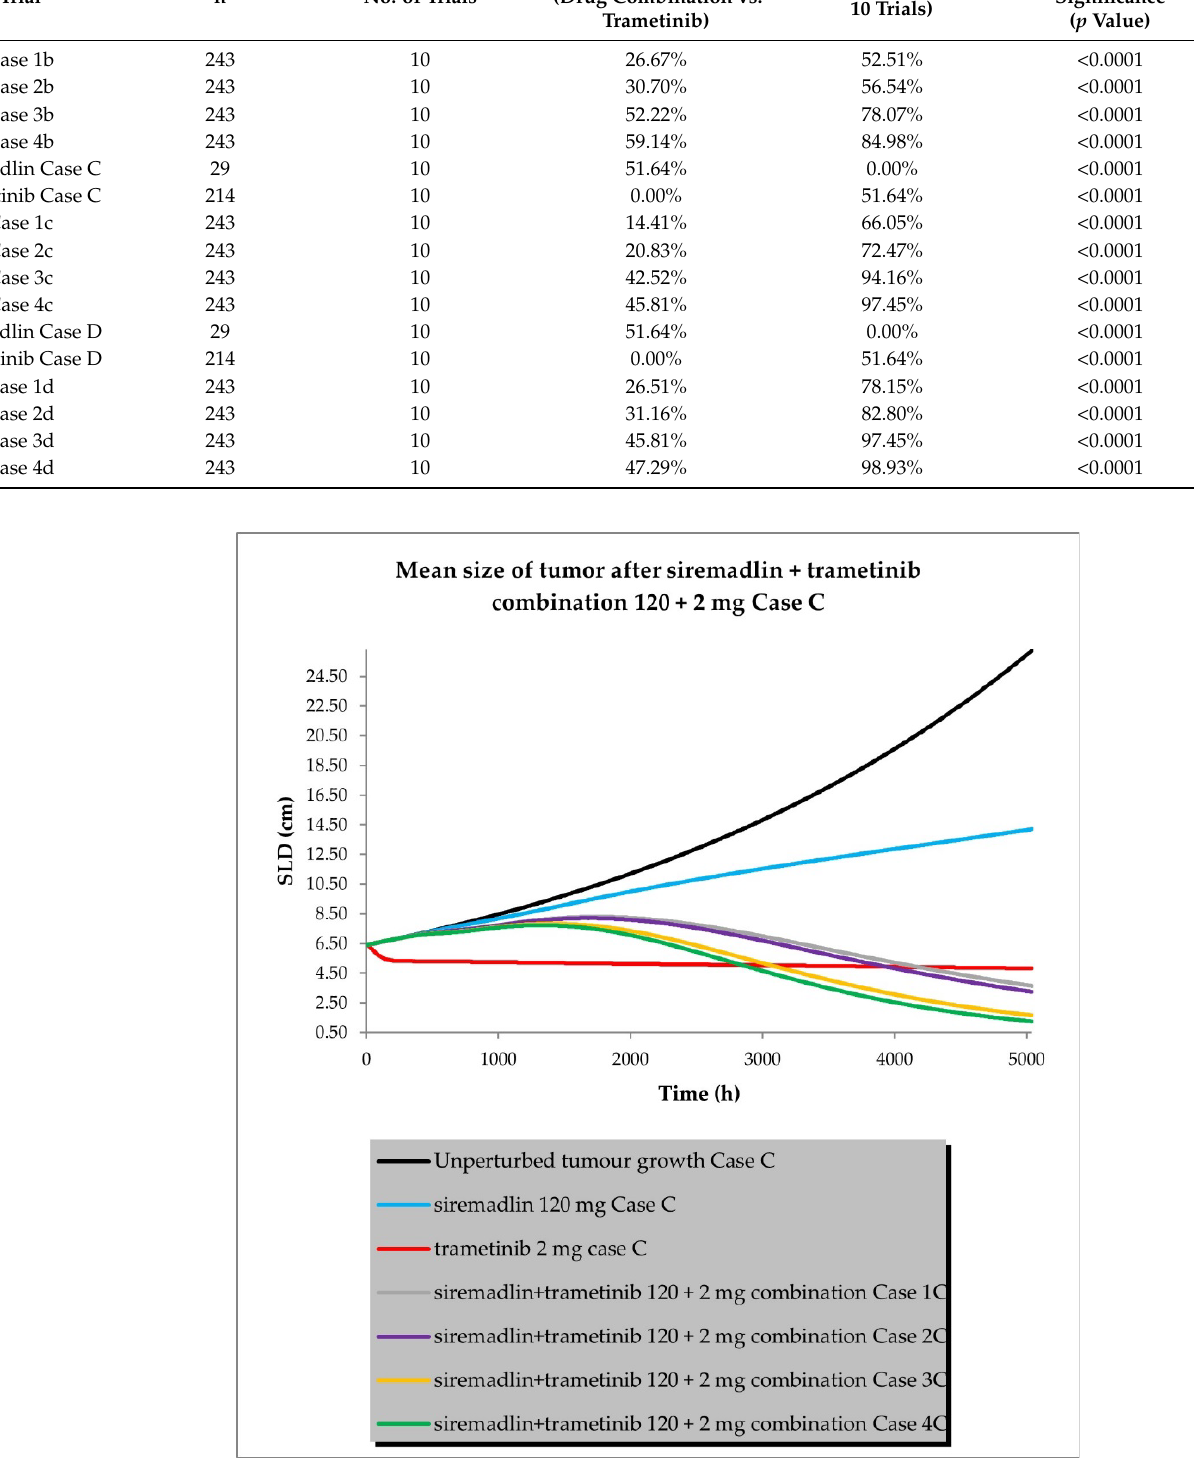
Figure 12. Siremadlin and trametinib combination’s 120 + 2 mg efficacy in population representative if melanoma cancer (Case C—high tumour growth, high initial tumour size, and low fraction of sensitive cells).